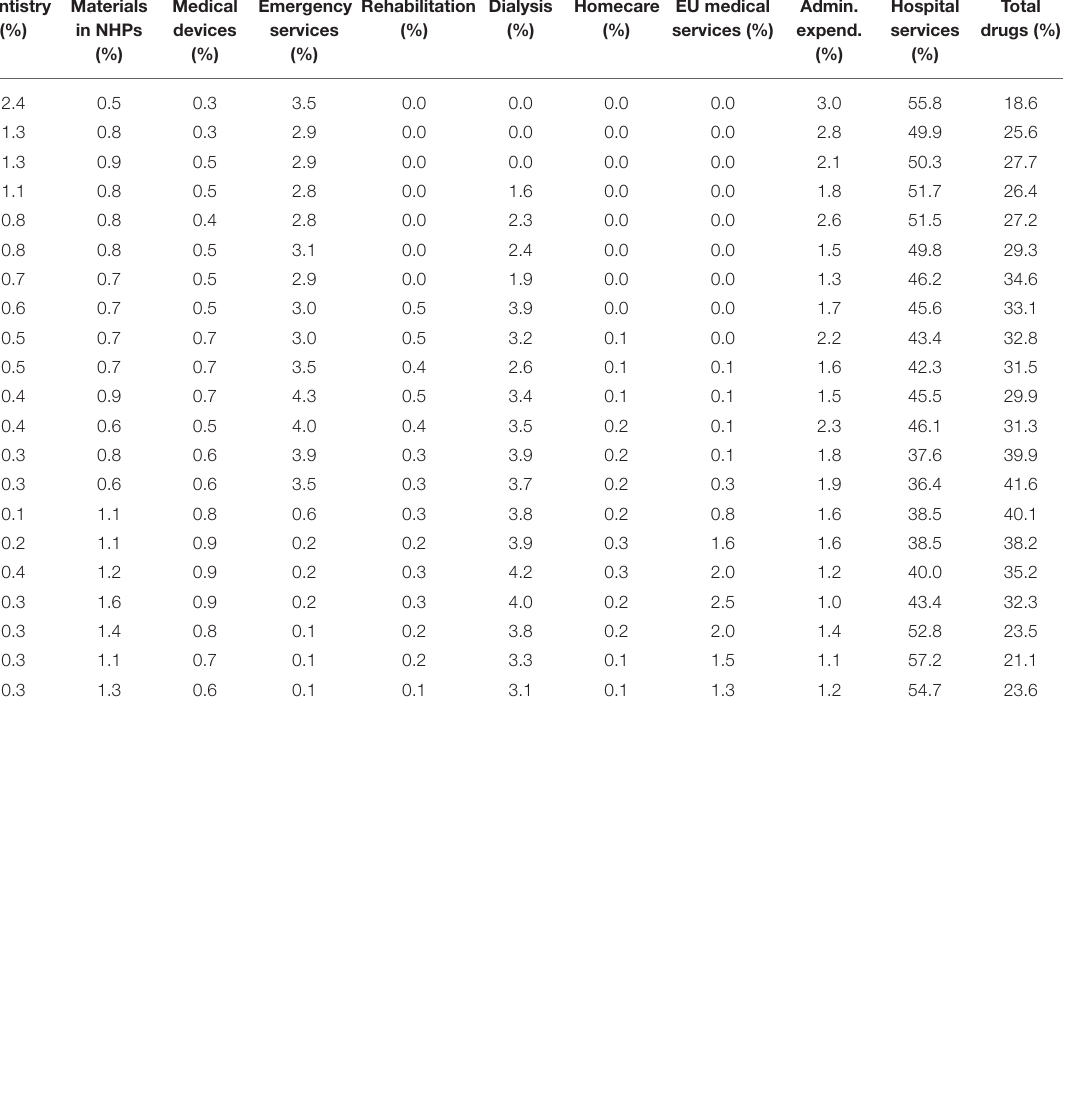
TABLE 1 | The share of different categories of health care provision in SHI expenditure between 1999 and 2019. Year Primary Multifunctional. care (%) centers